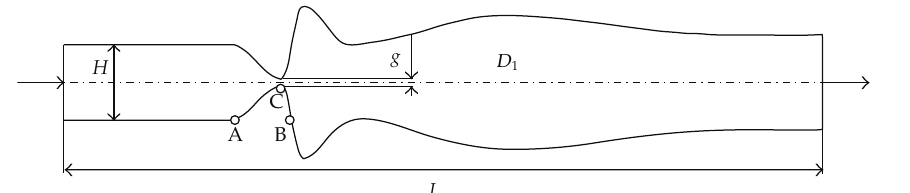
Figure 1: Computational domain D 1 . L (cid:4) 8 (cid:2) 160mm (cid:3) , H (cid:4) 0 . 8 (cid:2) 16mm (cid:3) , and g (cid:4) 0 . 08 (cid:2) 1 . 6mm (cid:3) — middle